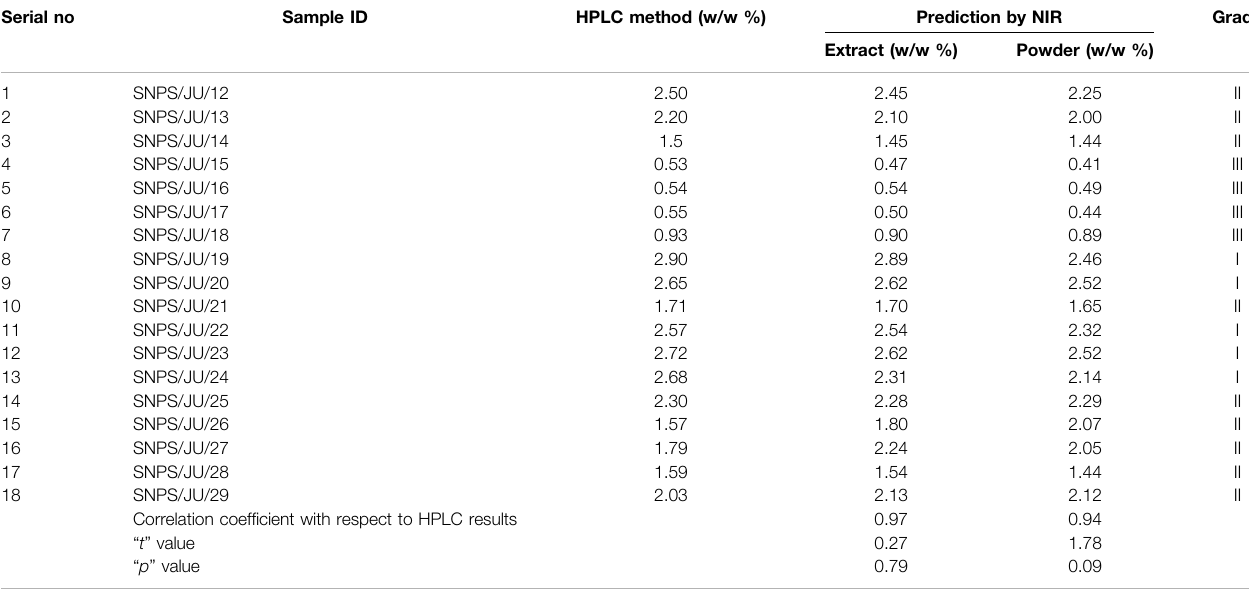
TABLE 1 | Result of HPLC and NIR and the grades of the 18 samples.